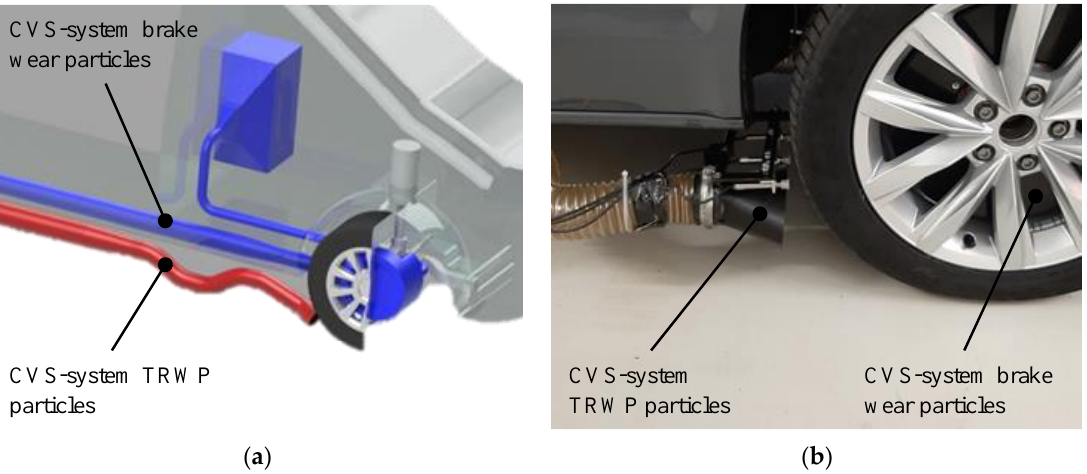
Figure 2. Test setup for vehicle-based particle emission measurement: ( a ) schematic illustration of sampling systems for brake wear (blue) and TRWP particles (red)—( b ) measurement setup mounted to the test vehicle [18].